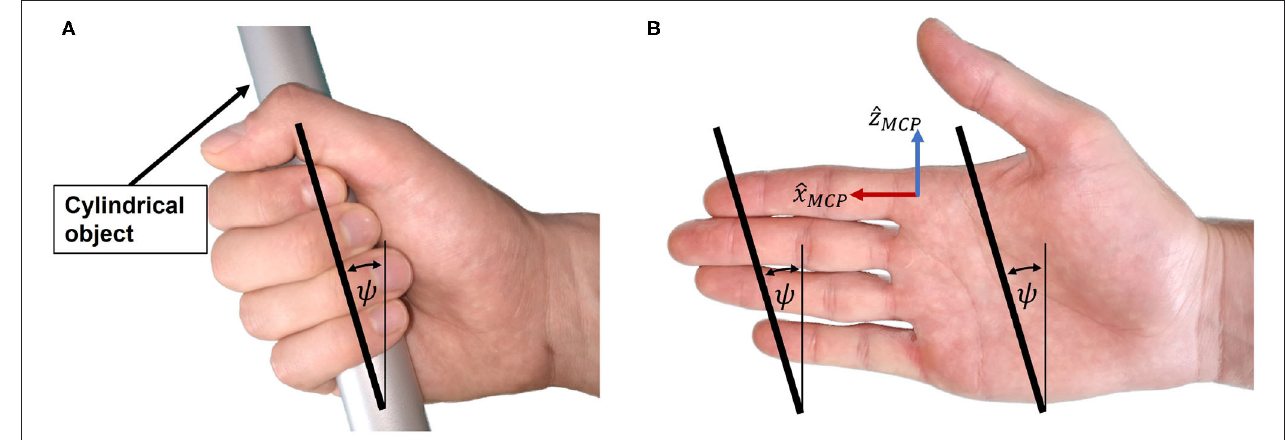
FIGURE 5 | Cylinder angle. (A) The hand encloses the cylindrical object with the cylinder angle. (B) Illustration of the cylinder angle in the open hand as well as the line connecting the fingertips from index to little